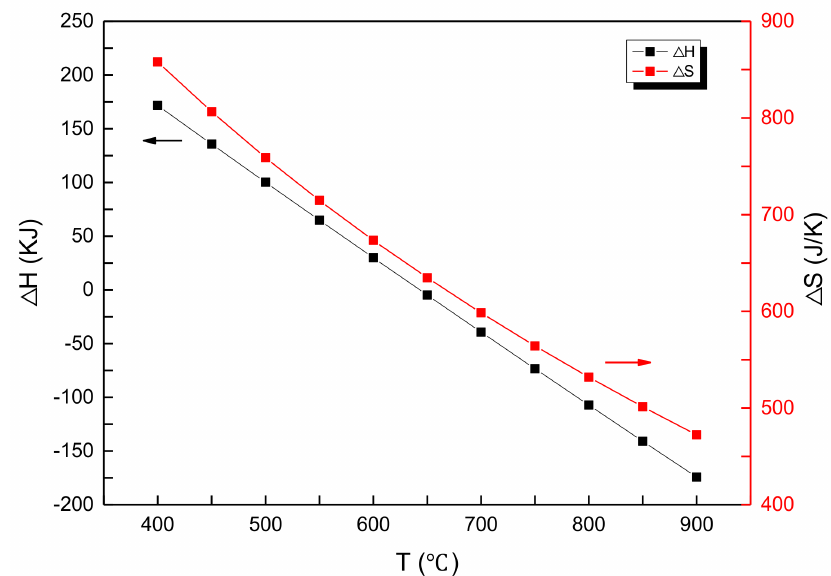
Figure 2. The dependence of ∆ H and ∆ S of Equation (2) with reaction temperature.